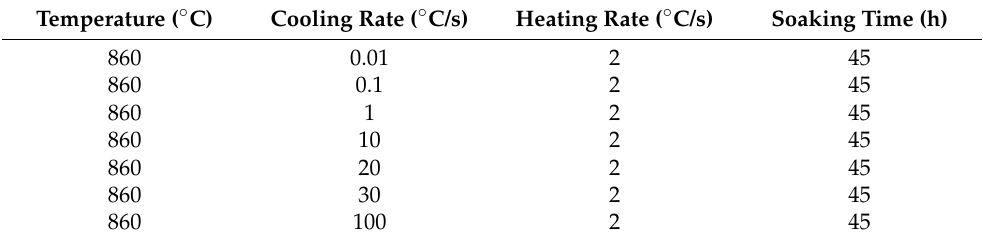
Table 1. Dilatometry parameters used on the three materials.